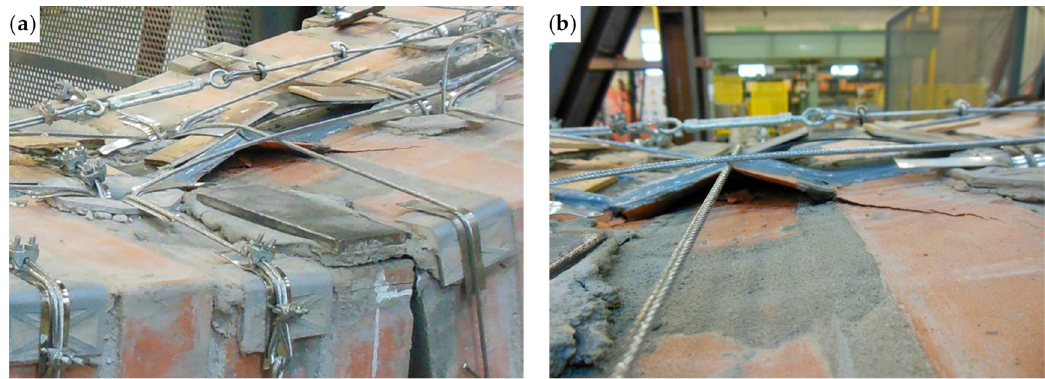
Figure 51. Buckling of the upper CFRP strip: ( a ) how the transverse and longitudinal steel wire ropes hold back the upper CFRP strip, counteracting delamination on the middle cross-section and ( b ) detail of the brick peeling caused by delamination.